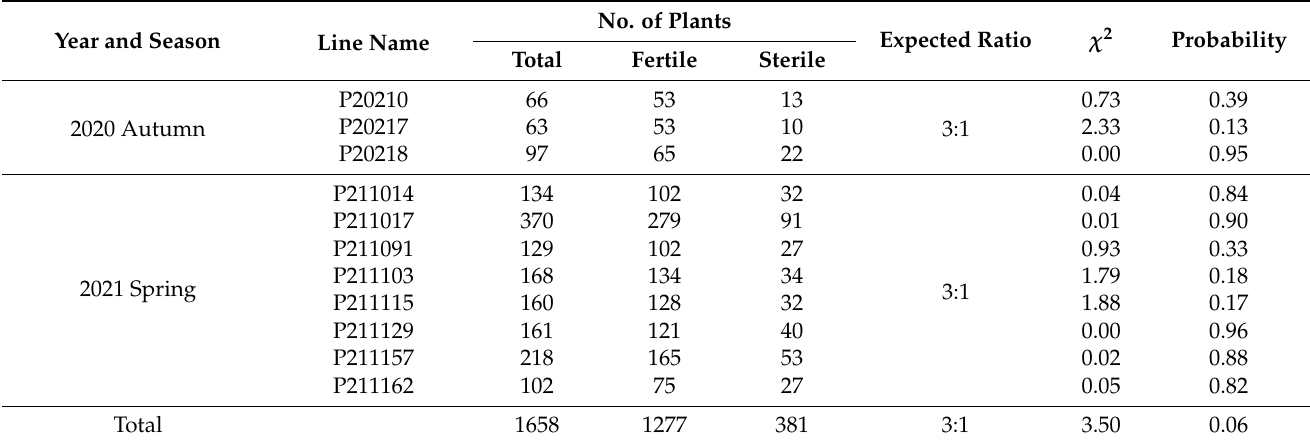
Table 2. Segregation patterns of male fertility and sterility in the pepper F 2 population derived from the cross HZ1A × HZ1C.